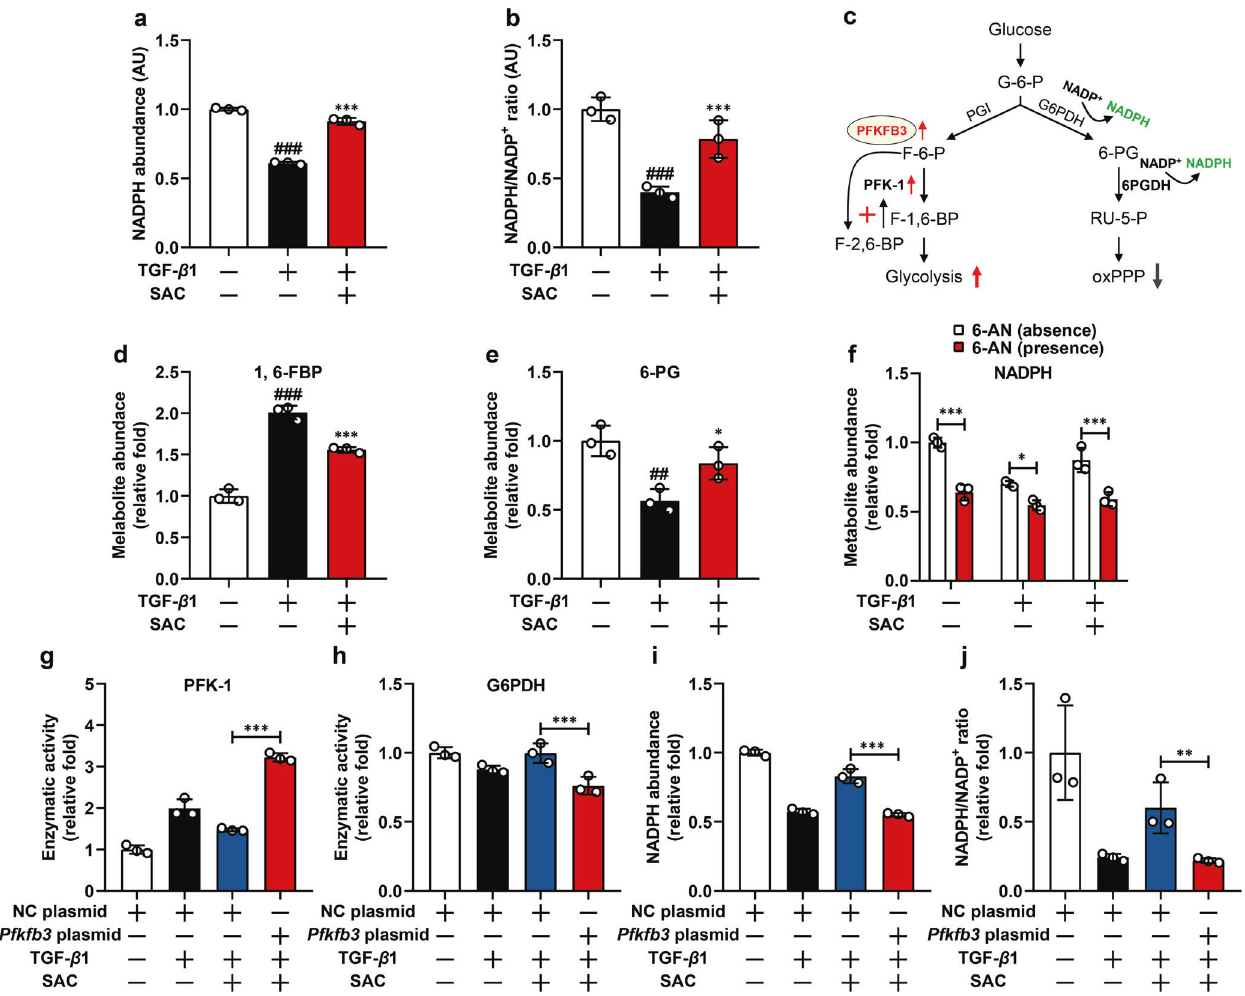
glycolysis and PPP. d , e Cellular F-1,6-BP and 6-PG abundance in vehicle, TGF- β 1 and SAC-treated ECs ( n = 3). f Cellular NADPH abundance in vehicle, TGF- β 1, SAC-treated ECs in the absence or presence of 6-aminonicotinamide (6-AN) ( n = 3). g , h Cellular PFK-1 activity, G6PDH activity, and ratio of PFK-1/G6PDH activity in negative control (NC) or Pfkfb3 plasmid transfected ECs following vehicle, TGF- β 1 and SAC treatment ( n = 3). i , j NADPH abundance and NADPH/NADP + ratio in negative control (NC) or Pfkfb3 plasmid transfected ECs following vehicle, TGF- β 1 and SAC treatment ( n = 3). Data are represented as mean ± SD. ## p < 0.01, ### p < 0.001 versus control group. * p < 0.05, ** p < 0.01, *** p < 0.001 versus model ( a , b , d , e ) group or indicated